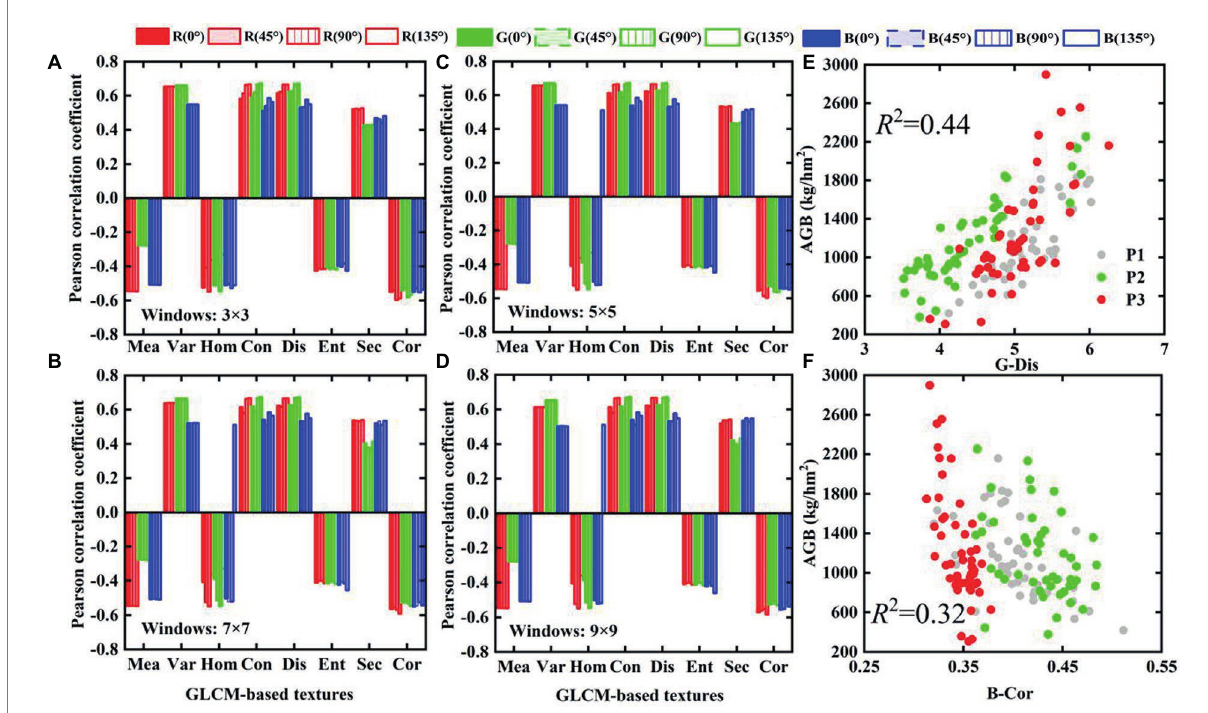
FIGURE 6 The relationship between GLCM-based textures and AGB in different directions and different windows: (A) 3 × 3, (B) 5 × 5, (C) 7 × 7, (D) 9 × 9, (E,F) scatter plots of G-Dis and B-Cor with AGB under 45 ° and 5 × 5 windows, respectively.